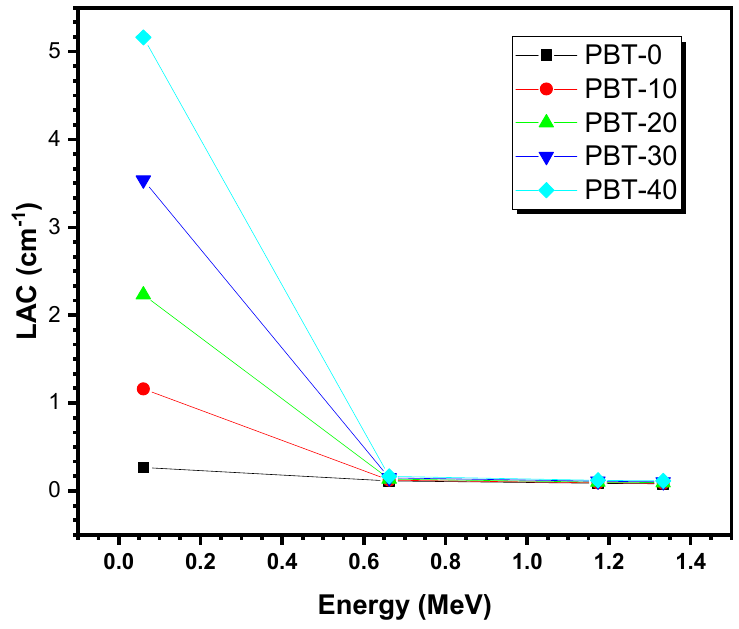
Figure 4. The linear attenuation coefficient (LAC) of the prepared polymer samples. The half value layer (HVL) of the polymers was calculated against energy and plotted in Figure 5. The aim of this figure is to compare the thicknesses of the polymers with each other to shield 50% of the incoming radiation and to study the impact of TeO 2 on this thickness. At 0.06 MeV, the HVL for PBT-0 is equal to 2.604 cm, which drastically drops to 0.597 cm when adding 10 wt% TeO 2 , 0.311 cm when 20% TeO 2 is added, and to 0.134 when 40% TeO 2 is added. In other words, the HVL values decrease from 2.604 to 0.134 cm when the TeO 2 content in the polymers increases from 0 to 40% at 0.06 MeV. When examining the HVL at other energies, the same trend can be found. At 0.662 MeV, the HVL values decrease from 6.073 to 4.193 cm due to the change in TeO 2 content, from 7.973 to 5.668 cm at 1.173 MeV, and from 8.514 to 6.061 cm at 1.333 MeV.